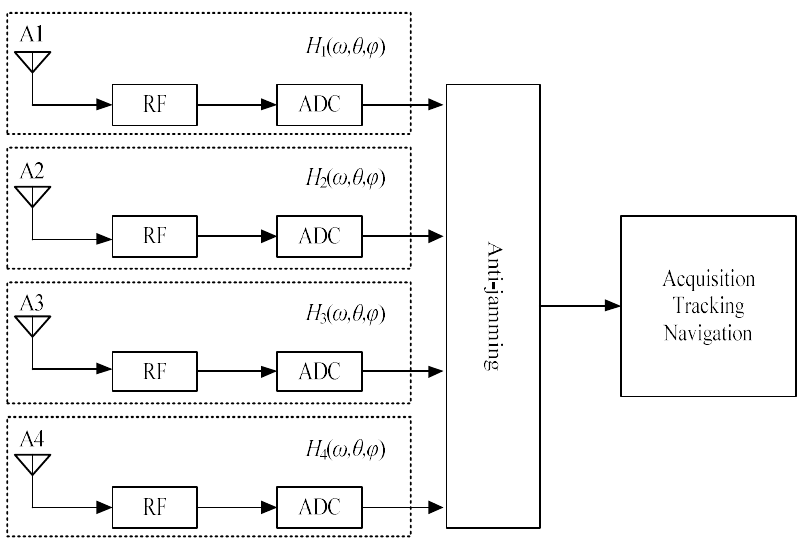
Figure 2. Antenna array structure.